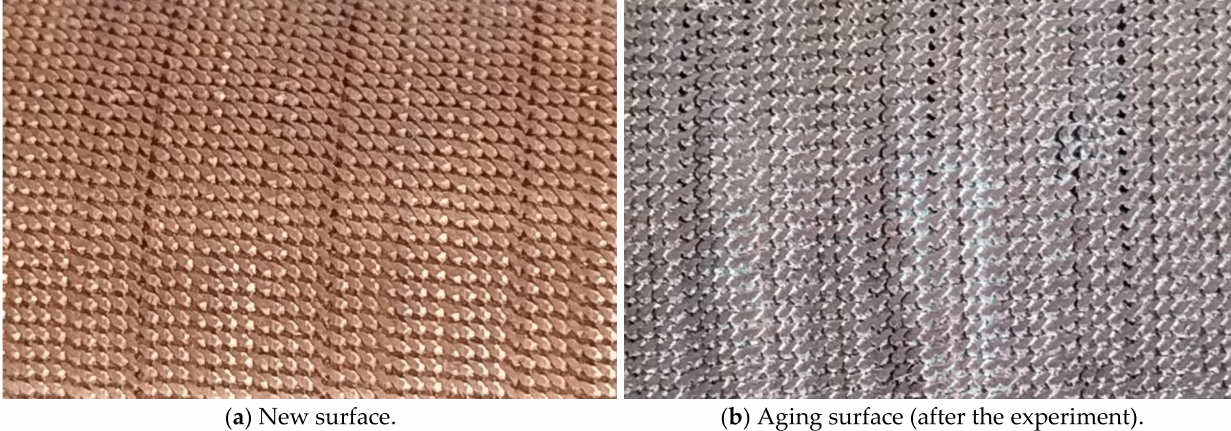
Figure 4. Comparison between ( a ) new GEWA-B5H surface and ( b ) aging GEWA-B5H